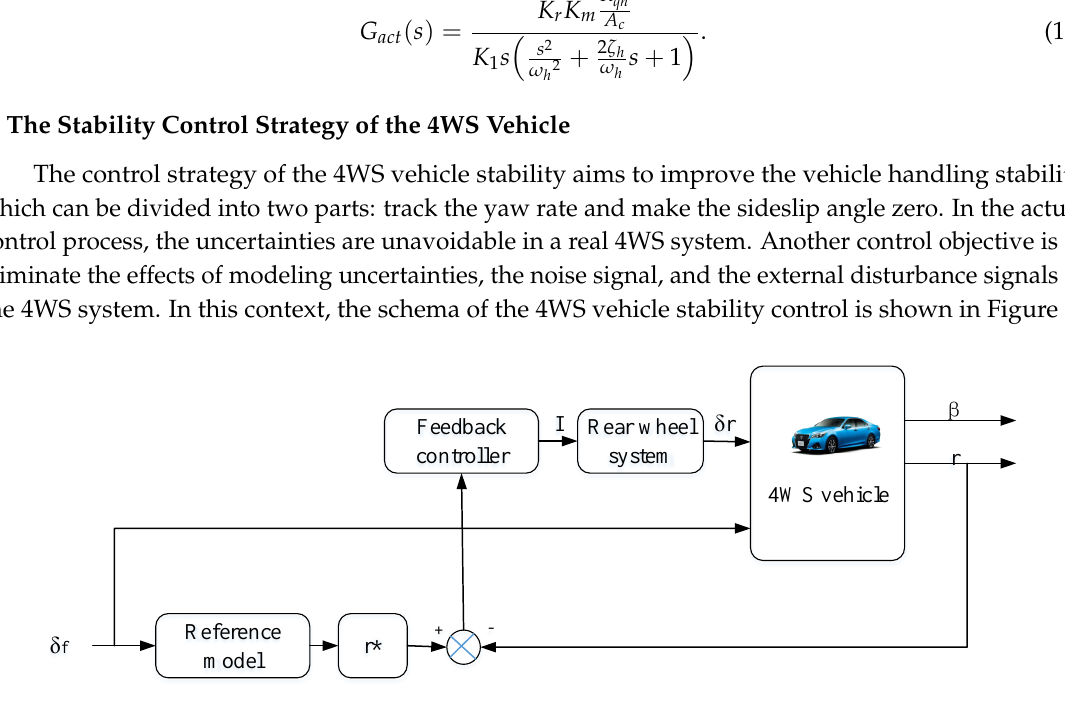
Figure 6. 4WS vehicle stability control schema ( r ∗ denotes the ideal yaw rate ).